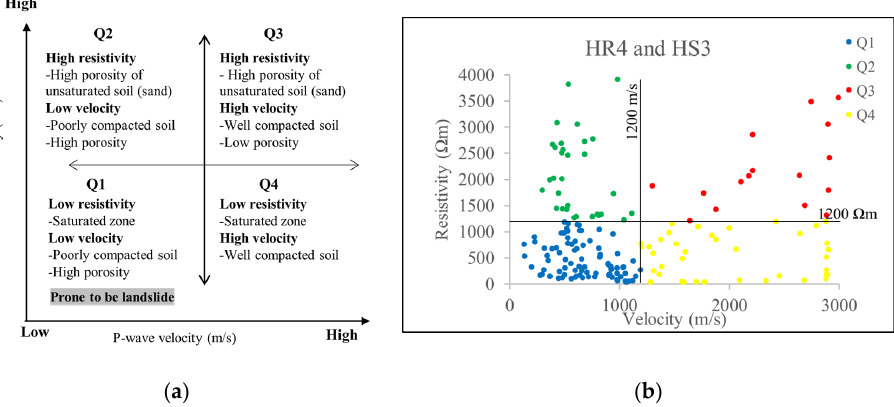
Figure 4. ( a ) Schematic relationship from P-wave velocity-resistivity; ( b ) the resistivity–velocity graph with a lower limit and upper limit used to classify the values, accordingly.